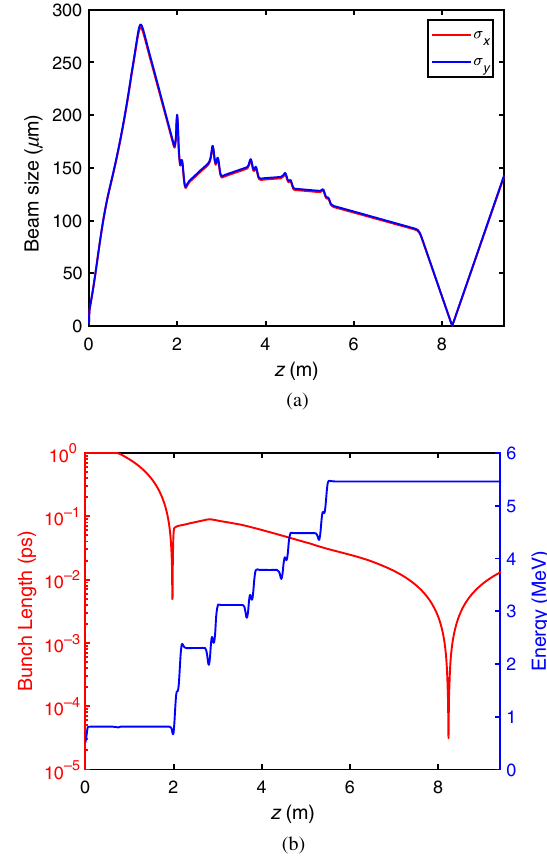
FIG. 5. (a) Beam width and (b) bunch length and energy throughout the injector at near zero charge for an example solution on the Pareto front. The sample (and clipping aperture) is located at z ¼ 8 . 228